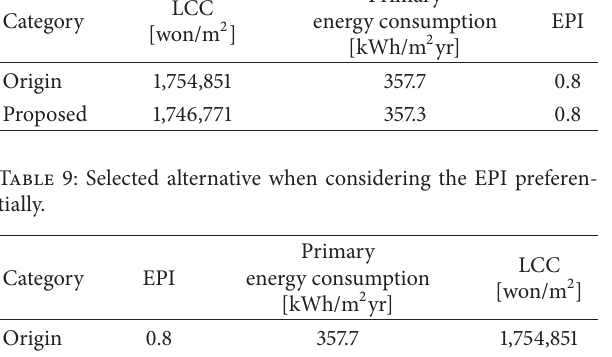
energy efficiency alternatives (Passive ECM List) for the target building were evaluated.